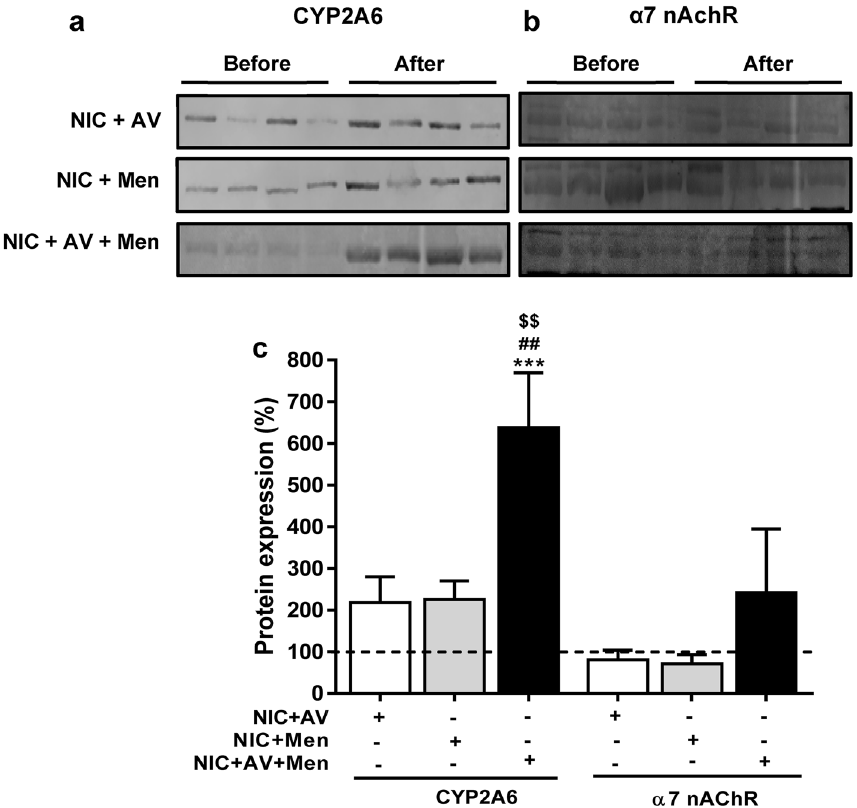
Figure 3. Expression of nicotine-metabolizing and nicotine receptor proteins in EVs. EVs were isolated from rat plasma obtained ‘before’ and ‘after’ self-administered nicotine in the presence of either AV, menthol or combined (NIC: Nicotine, AV: Audiovisual, Men: Menthol). Representative western blots of CYP2A6 ( a ) and α7 nAChR ( b ). The ‘before’ represent the plasma EVs obtained before the self-administered nicotine, whereas ‘after’ represent plasma EVs obtained after the self-administered nicotine with menthol and AV cue alone or combined. ( c ) Densitometry analysis. Plasma EVs obtained ‘before’ self-administered nicotine were considered as 100%. Statistical analyses were carried out by using one-way ANOVA. Results are expressed as means ± S.E.M of n = 4 experiments. ***p < 0.001, in comparison with ‘before’ nicotine self-administration. $$p < 0.01 in comparison with ‘after’ self-administered nicotine with AV. ##p < 0.01 in comparison with ‘after’ self-administered nicotine with